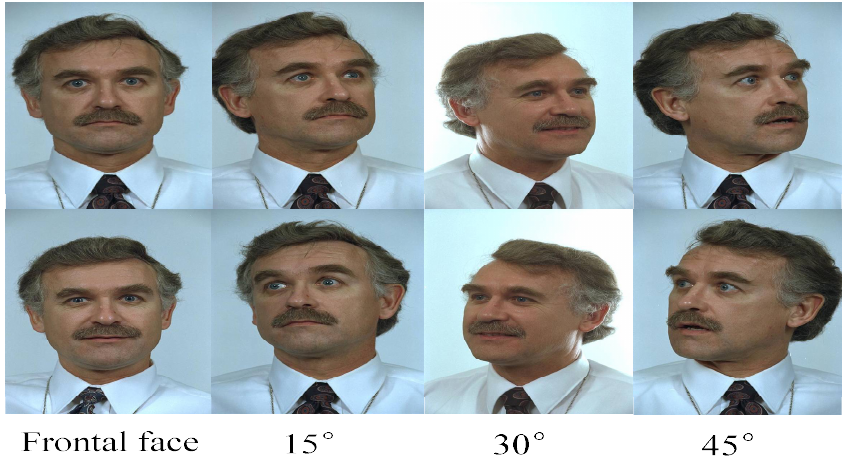
Figure 8. Some samples with multi-view. Table 1. Comparison of our method and other methods with multi-view.